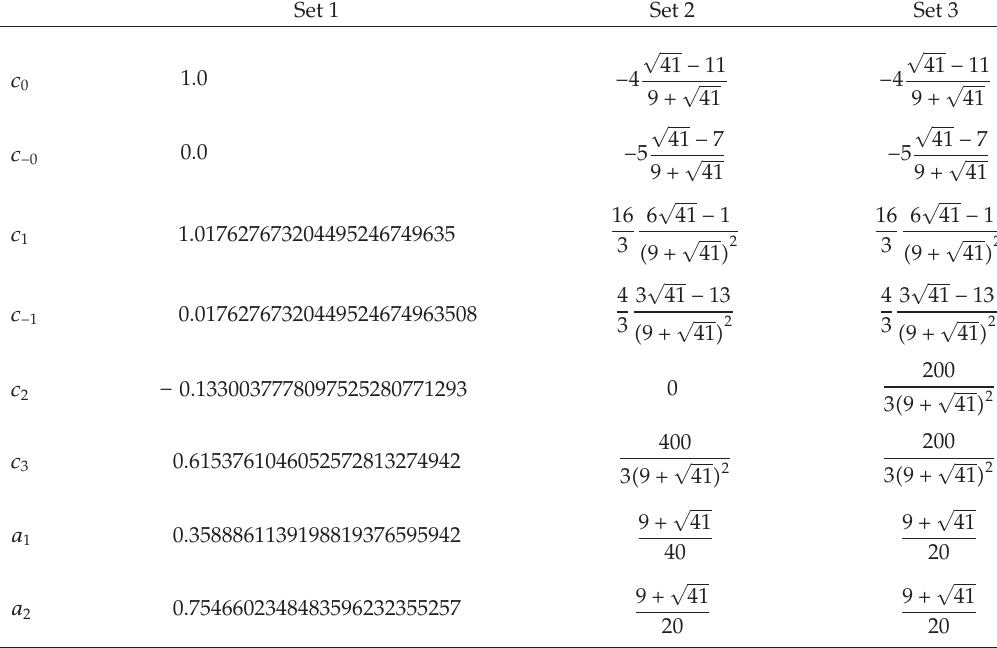
Table 2: Optimized ARK4 parameter